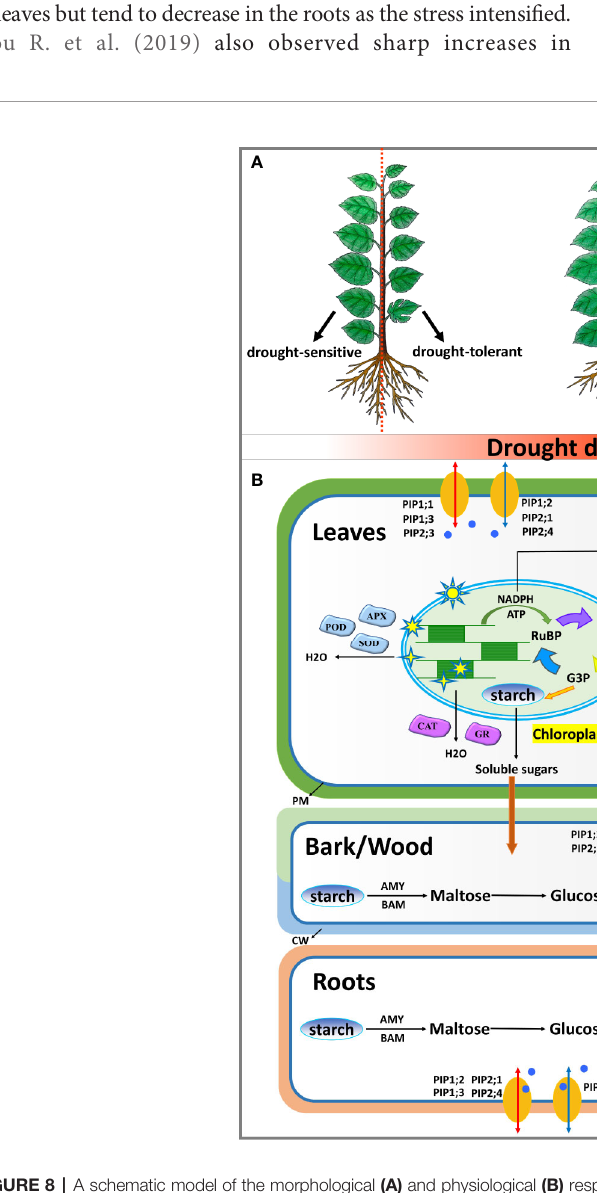
FIGURE 8 | A schematic model of the morphological (A) and physiological (B) responses to progressive soil water de fi cit in mulberry. Drought tolerant cultivar Wubu generally displayed delayed stress responses in comparison with drought sensitive cultivars, i.e. 7307. When the stress level was relatively mild, Wubu exhibited no or slight responsiveness in plant water contents, PIP expression regulation, leaf chlorophyll concentrations, soluble sugars, MDA production, free proline accumulation, but displayed strong changes in chlorophyll in bark, starch, and ROS in roots and activities of antioxidant enzymes. However, all these responses were dramatically intensi fi ed as the stress level became severe. All the examined cultivars demonstrated differentially expressed patterns of PIPs , decreased starch concentrations, increased osmoregulatory substances, shifted ROS production and scavenging under progressive drought stress. AKG a -ketoglutaric acid; AMY, a - amylase; APX, ascorbate peroxidase; BAM, b -amylase; CAT, catalase; Glu, glutamic acid; G3P, glyceraldehyde 3-phosphate; GR, Glutathione reductase; P5C, 1- pyrroline-5-carboxylic acid; PG, phosphoglycerate; POD, peroxidase; RuBP, ribulose-1,5-bisphosphate; SOD, superoxide